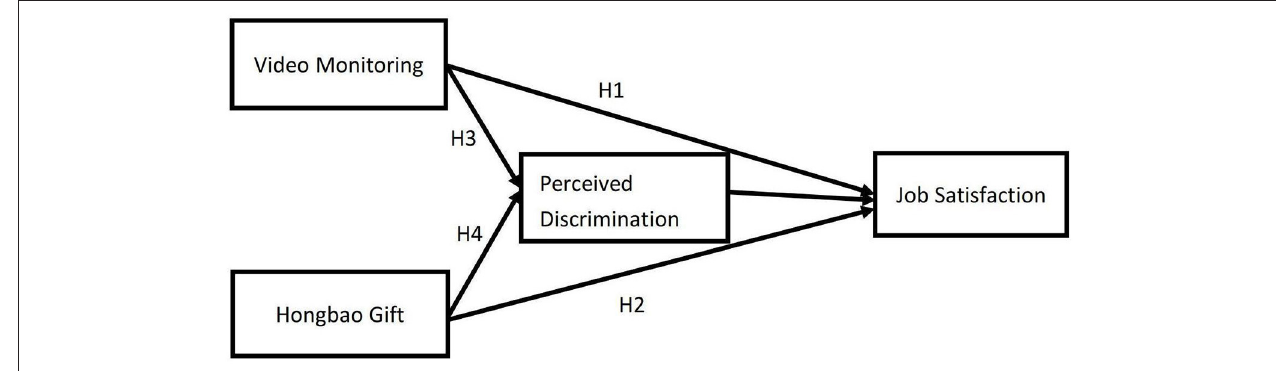
FIGURE 1 | Impact mechanism of the effects of video monitoring and hongbao gifts on the job satisfaction of domestic workers.